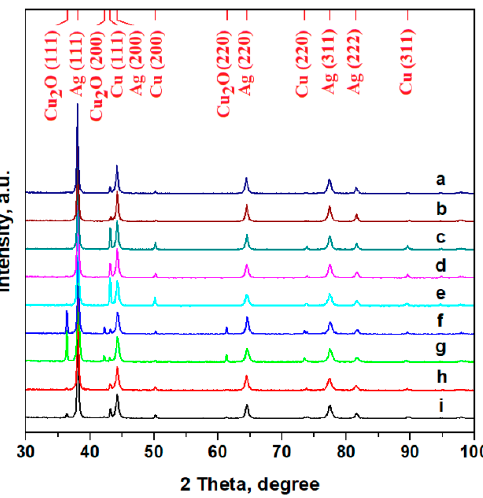
Figure 4. XRD spectra for the investigated coinsissued in: (a) 1619, (b) 1620, (c) 1621, (d) 1622, (e) 1623, (f) 1624, (g) 1625, (h)1626, and (i)